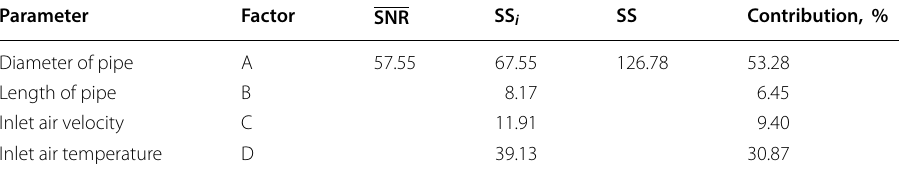
Table 8 Contribution of each parameter for maximum heat transfer rate in EATHE